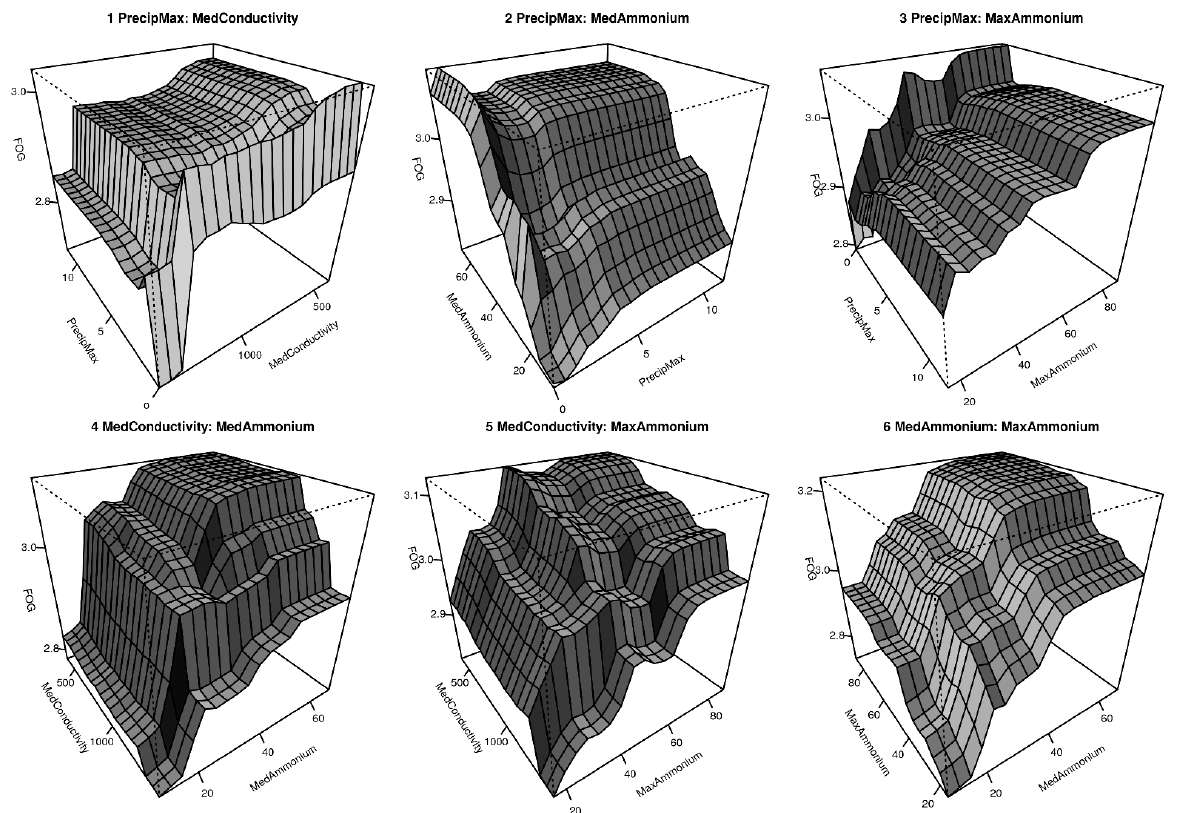
Figure 11. Sensitivity analysis (two variables).